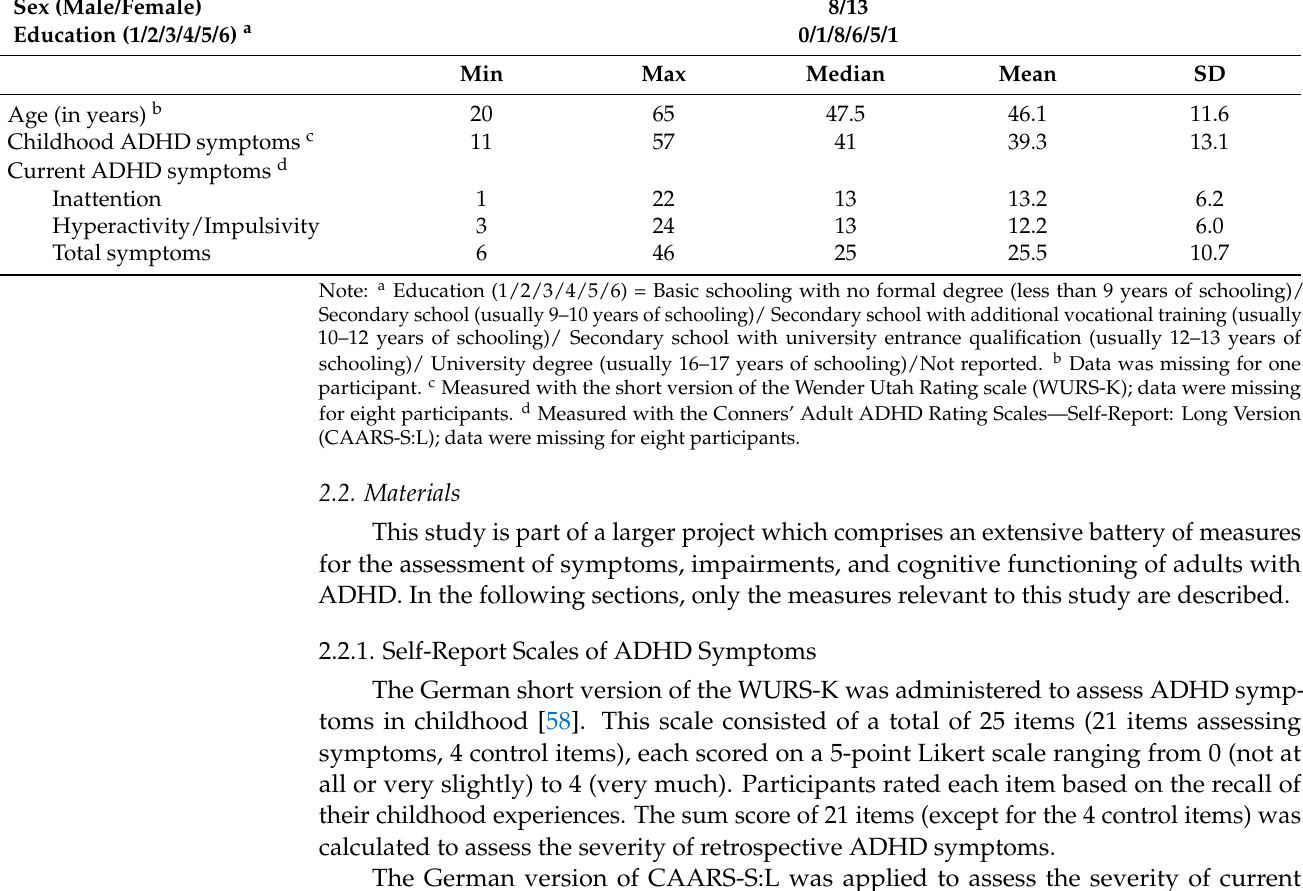
Table 1. Descriptive information and ADHD symptoms of all participants. Adults with ADHD ( n =